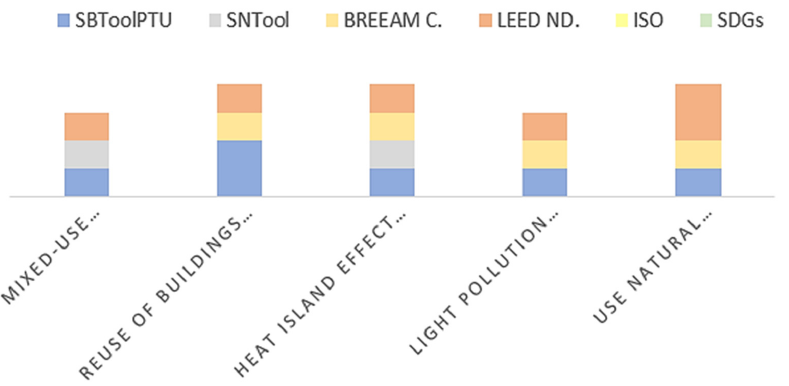
Figure 16. Frequency distribution of each indicator, which is included in three or four sustainability tools: SBTool PT _Urban (2018), SNTool (2020), BREEAM Communities (2012), and LEED-ND (2018).